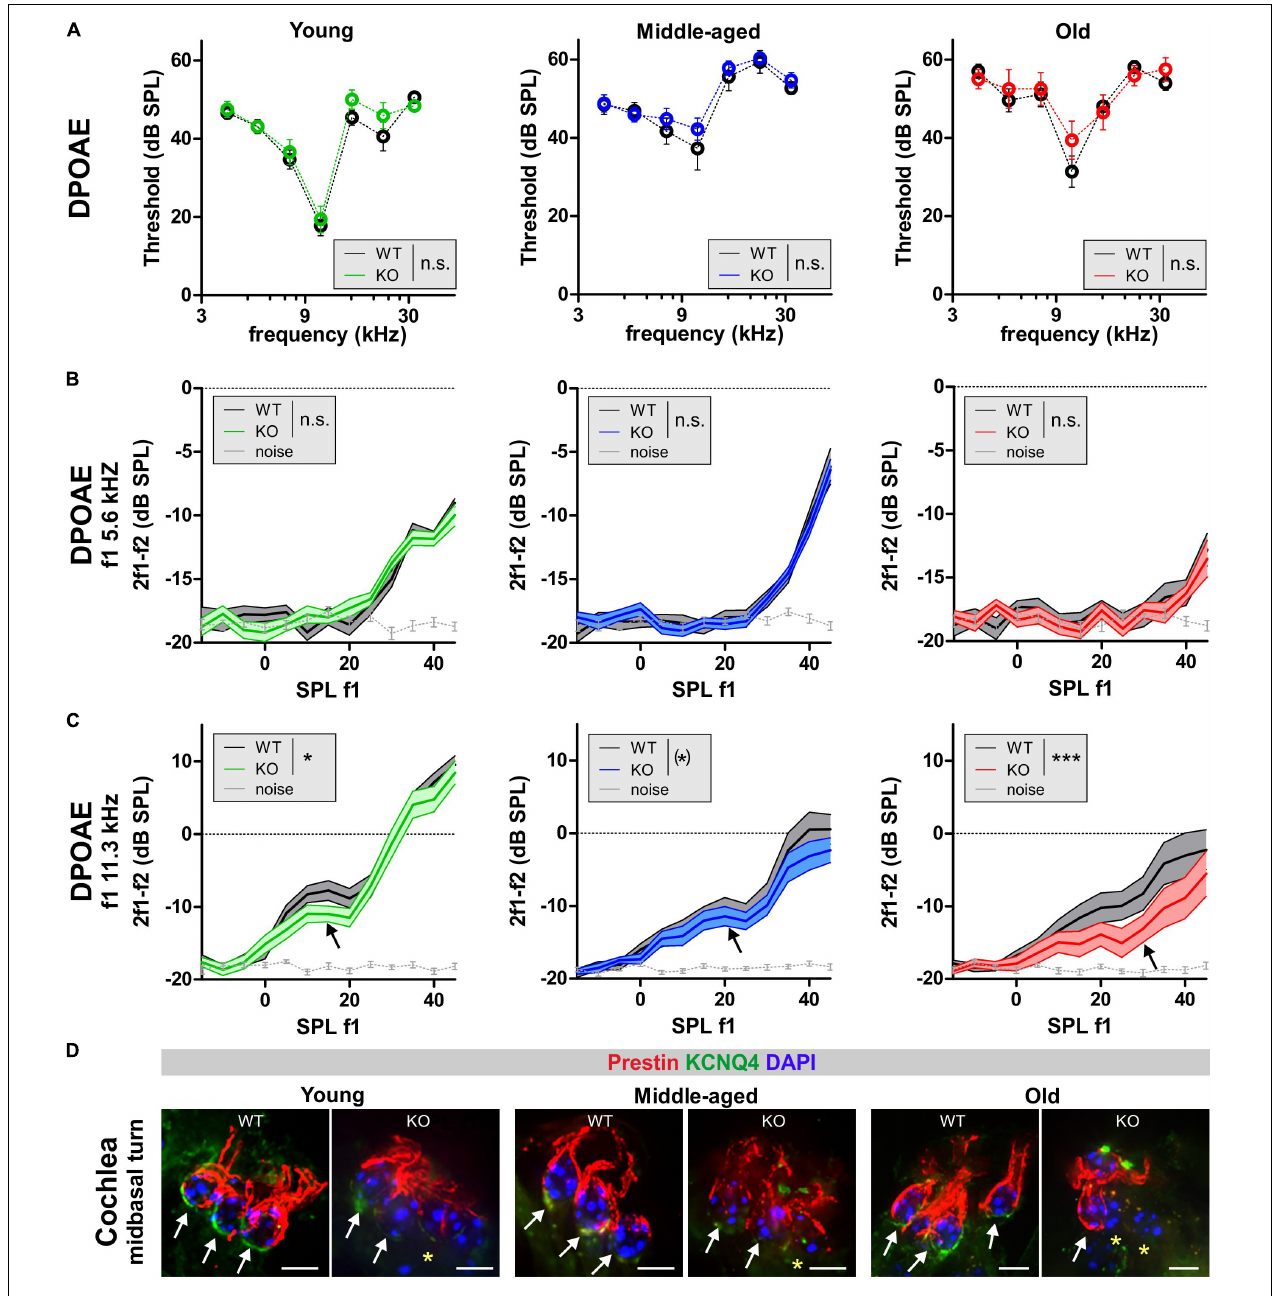
FIGURE 3 | DPOAEs and expression of KCNQ4 in GC-A WT and GC-A KO mice at different ages. (A–C) OHC function assessed from distortion-product otoacoustic emissions (DPOAEs) that are generated by electromechanical responses of OHCs. (A) Frequency-specific thresholds of DPOAE signals for pure-tone sounds from f2 = 4–32 kHz did not differ between GC-A KO and WT mice [young: two-way ANOVA, F (1,84) = 0.04, P = 0.8510, n = 8/16 mice/ears each; middle-aged: two-way ANOVA, F (1,132) = 1.54, P = 0.2157, WT n = 6/12 mice/ears KO n = 8/16 mice/ears; old: two-way ANOVA, F (1,247) = 0.52, P = 0.4697, WT n = 14/27 mice/ears KO n = 10/20 mice/ears]. (B) DPOAE growth function in response to pure-tone sounds at f1 = 5.6 kHz were similar between GC-A KO and WT mice in all three age groups [young: two-way ANOVA, F (1,382) = 0.17, P = 0.679, n = 8/16 mice/ears each; middle-aged: two-way ANOVA, F (1,577) = 0.00, P = 0.9879, WT n = 10/20 mice/ears KO n = 14/28 mice/ears; old: two-way ANOVA, F (1,382) = 0.59, P = 0.4439, n = 8/16 mice/ears each]. (C) DPOAE growth function in response to pure-tone sounds at f1 = 11.3 kHz were reduced in GC-A KO compared to WT mice in all three age groups [young: two-way ANOVA, F (1,382) = 4.40, P = 0.0367, n = 8/16 mice/ears each; middle-aged: two-way ANOVA, F (1,577) = 3.34, P = 0.0681, WT n = 10/20 mice/ears KO n = 14/28 mice/ears; old: two-way ANOVA, F (1,382) = 14.01, P = 0.0002, n = 8/16 mice/ears each]. Mean ± SEM. ∗ P < 0.1; ∗ P < 0.05; ∗∗∗ P < 0.001. (D) The intactness of the OHC phenotype was investigated by immunohistochemical staining for KCNQ4 (green) and the motor protein prestin (red) as markers for OHC viability and their capacity for electromechanical responses. Staining for KCNQ4 in cochlear OHCs of GC-A mice was reduced in OHCs (upper panel) in comparison to WT mice, while prestin seems to be only slightly reduced due to degeneration of membrane. Nuclei were stained with 4’,6-diamidin-2-phenylindol (DAPI, blue). Yellow asterisk shows absence of KCNQ4 in OHCs. Scale bars: 5 µ m.